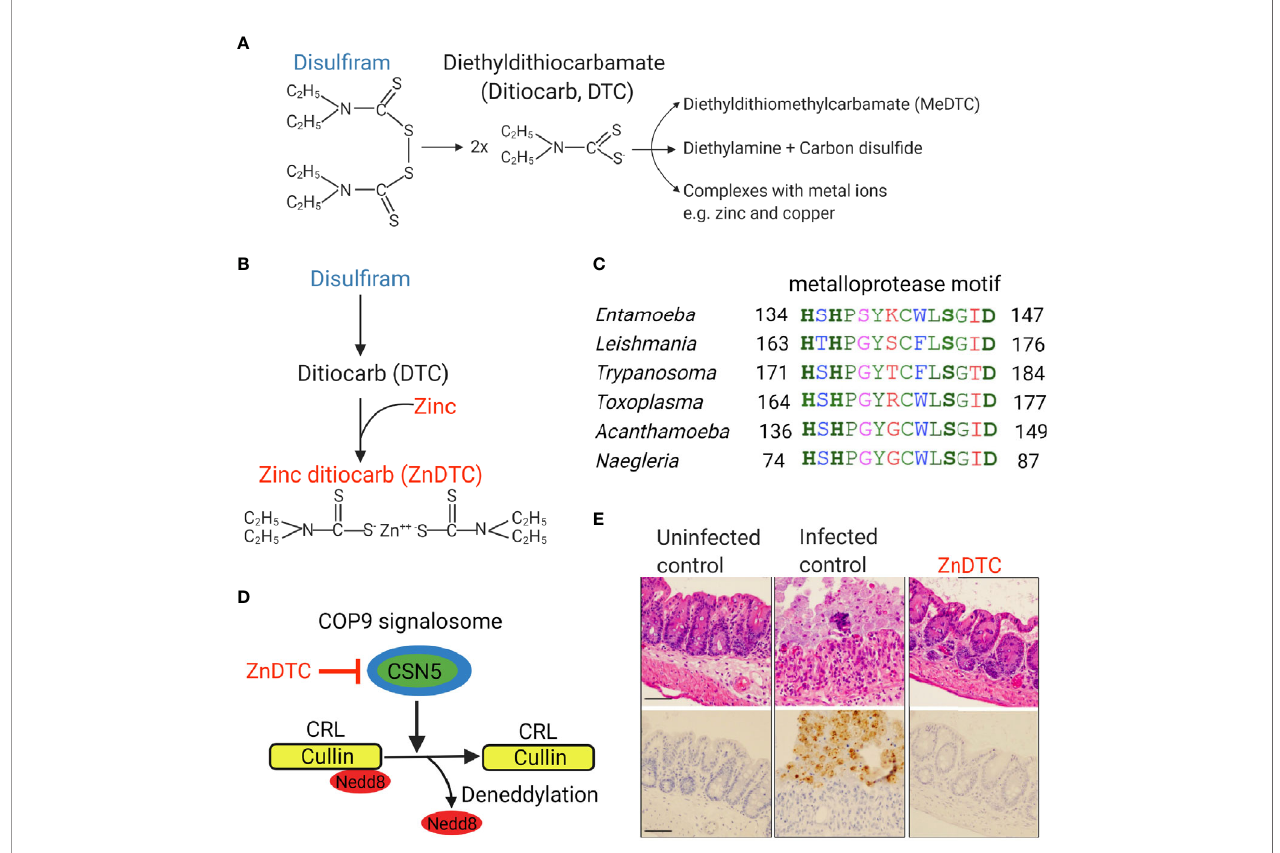
FIGURE 1 | Zinc ditiocarb (ZnDTC), a main metabolite of disul fi ram, is potently active against E. histolytica parasites in a preclinical animal model. (A) Disul fi ram and its metabolites. (B) ZnDTC is formed from the combination of disul fi ram and zinc supplement. (C) Multiple sequence alignment of the conserved metalloprotease motif of COP9 signalosome subunit 5 (CSN5) from E . histolytica and other pathogenic parasites (EHI_050500, TGARI_308590, TcCLB.507083.60, LBRM2903_160015100, ACA1_074760, NF0060740). Identical (green), conserved (blue), semi-conserved (pink) and non-conserved residues (red). (D) Schematic of how ZnDTC inhibits cullin deneddylation by the COP9 signalosome. (E) Representative H&E staining and immunohistochemical analysis of the cecum of infected mice after 5 days of treatment. Speci fi c anti – E. histolytica antibody was used for immunohistochemical staining of trophozoites (brown). Numerous parasites in the infected control, absent in the ZnDTC treated mice and uninfected control. The treatment group received 50 mg/kg disul fi ram plus 1 mg/kg zinc gluconate. Panels are reproduced from (Ghosh et al., 2020) with